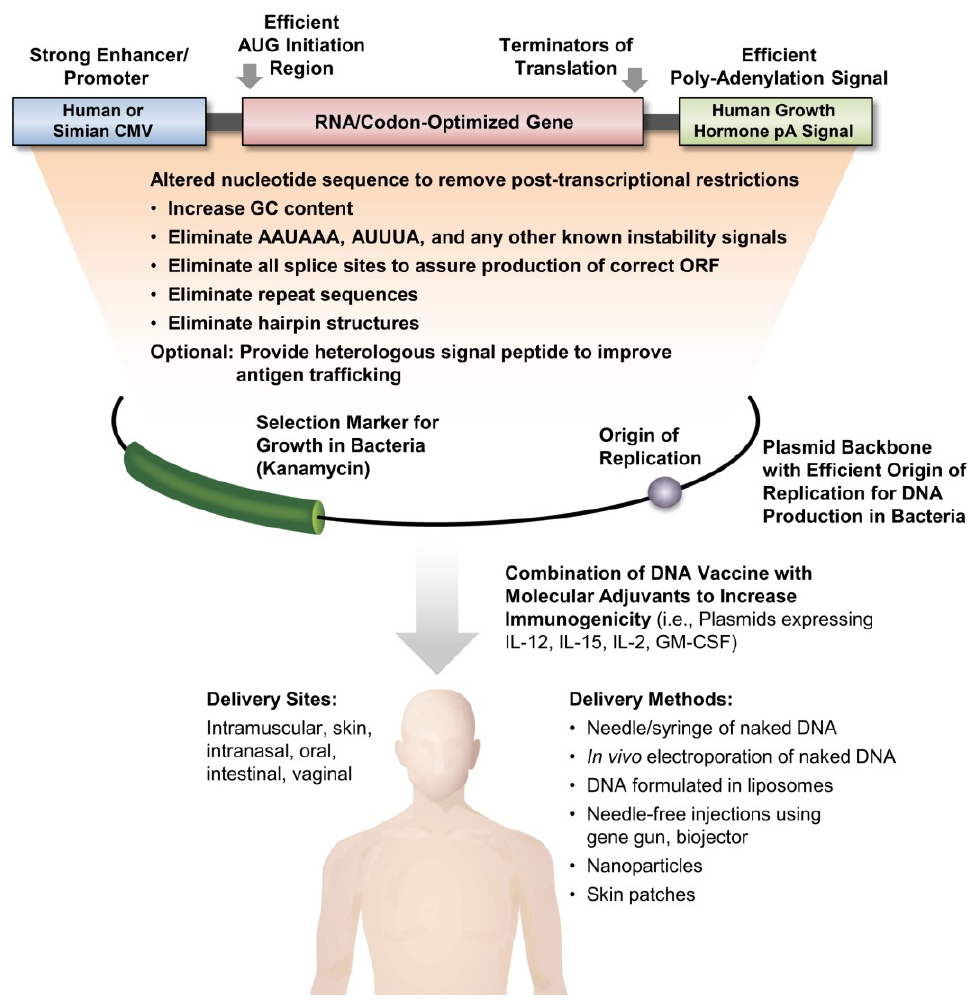
Figure 1. Optimization of DNA expression and delivery: from bench to bedside.